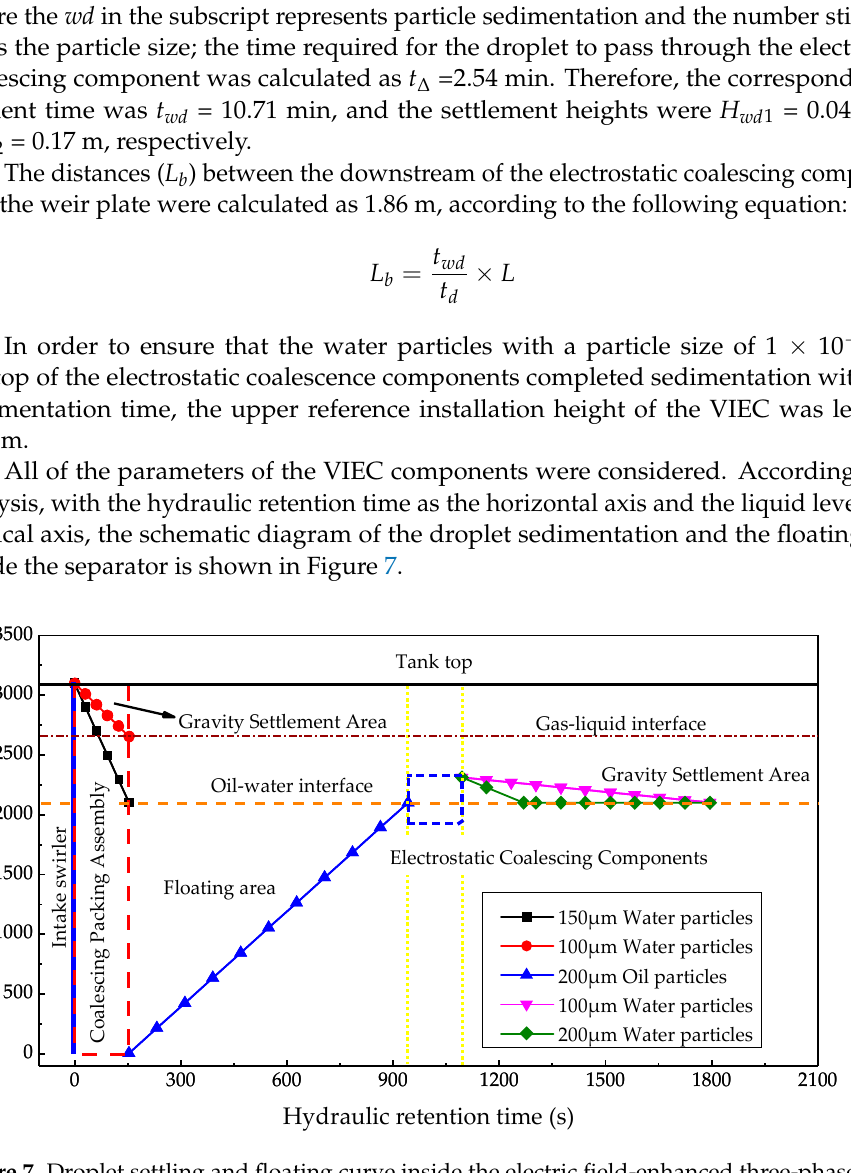
Figure 8. Schematic diagram of the overall structure of the test prototype. The electric-field-enhanced oil–water separation skid was a separation tank with a built-in VIEC component. Its design size was 5.2 m (length) × 2.4 m (width) × 3.695 m (height), the design flow was 10 m 3 /h, the volume was 8.7 m 3 , the design pressure was 1.6 MPa, and the design temperature was 150 °C. The inlet was set at the upper left of the tank and the water and oil outlets were on both sides of the weir plate at the bottom of the tank. Multiple sampling ports were set at the inlet of the separator, at the outlet of the oil phase, and between the VIEC components and the weir plate. In order to assist in regu- lating the internal liquid level of the separator, safety valves, flow meters, liquid level gauges, pumps and other related instruments were also set up. To better adapt to the changes in the physical properties of the crude oil, the power supply adopted the self-developed high-frequency/high-voltage AC pulse with the func- tion of increasing the voltage in stages within pulse width, which greatly eliminated the adverse effects of spikes on the system under high-frequency/high-voltage working con- ditions, and had high operating stability. This was also a key to the efficient operation of the electric-field-enhanced oil–water separator [38]. After the power supply was boosted by the transformer, the AC pulse output was realized, with a frequency of ~500 Hz to 20